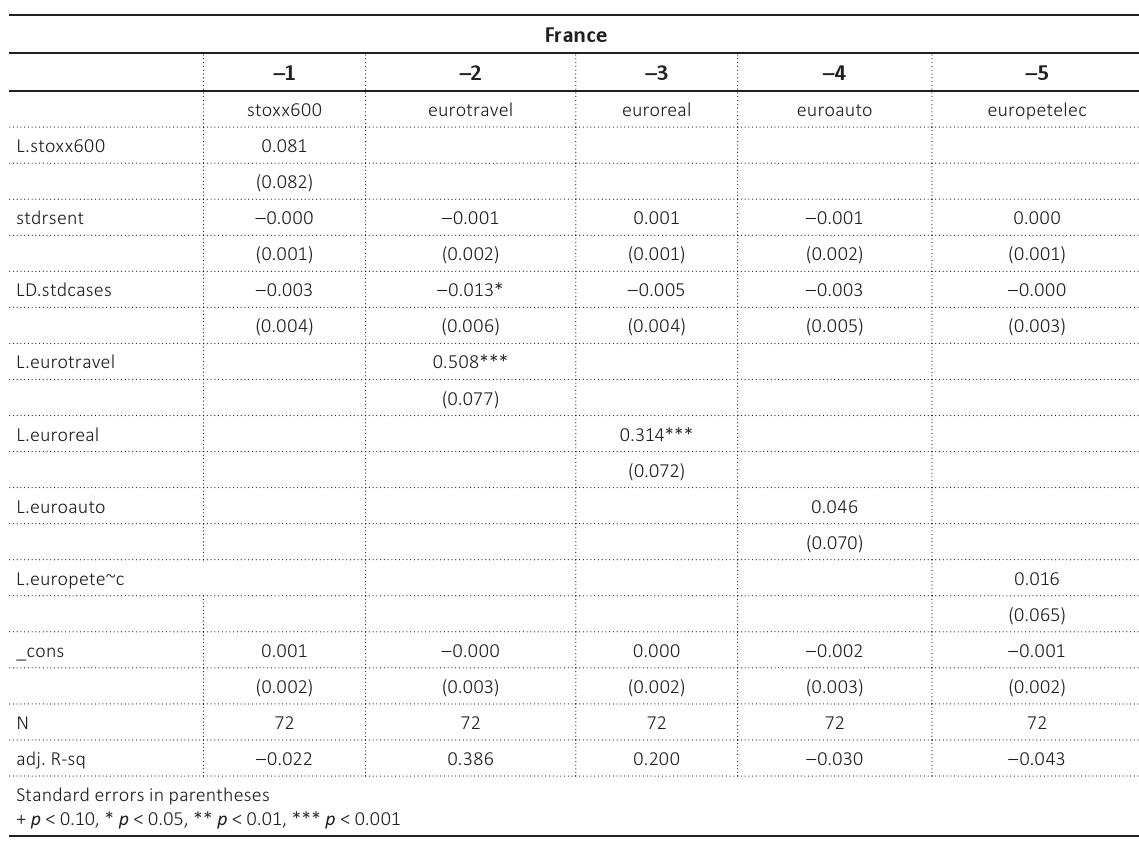
Table 6. OLS robust regressions for